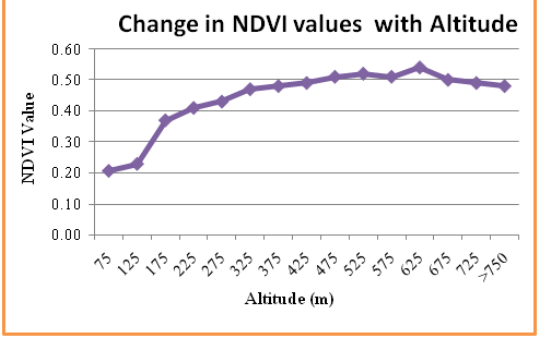
. Figure 4. Change in NDVI value with altitude Healthy vegetation is represented by high NDVI values between 0.1 and 1. Inversely, non-vegetated surfaces such as water bodies yield negative values of NDVI because of the electromagnetic absorption quality of water. Bare soil areas represent NDVI values which are closest to 0 due to high reflectance in both the visible and NIR portions of the EMS (Lilles and Kiefer 1994). The NDVI value change with aspect is shown in figure 5.